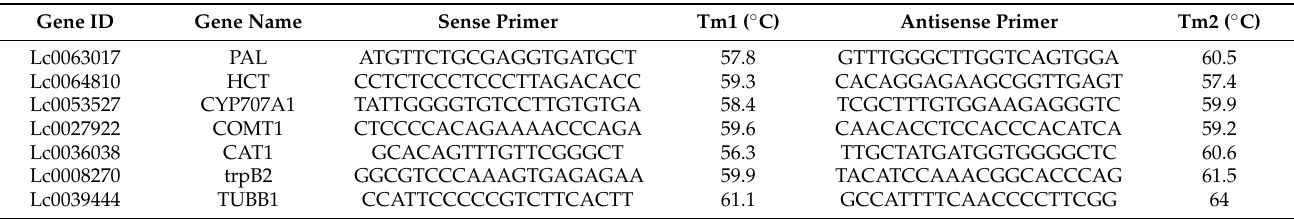
Table A2. The signi fi cance test for the e ff ects of sex, Pb treatment, and their interaction on the pa- rameters considered in this study. ns, non-signi fi cant; *, p < 0.05; **, p < 0.01; Fs, sex e ff ect; Fp, Pb content e ff ect; Fsxp, interaction e ff ect of sex and Pb content. P:Fs